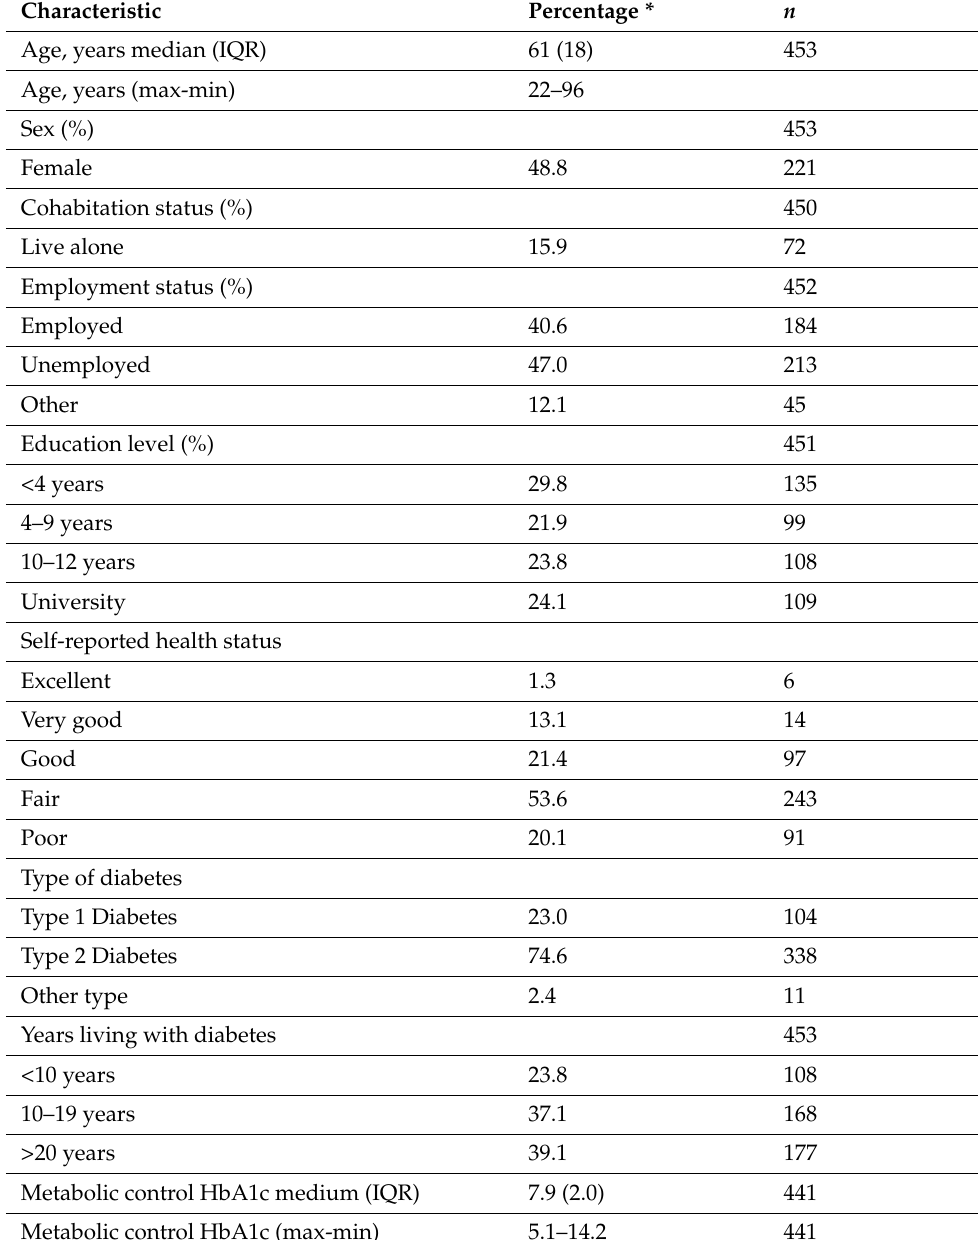
Table 2. Sociodemographic and clinical characteristics of participants.